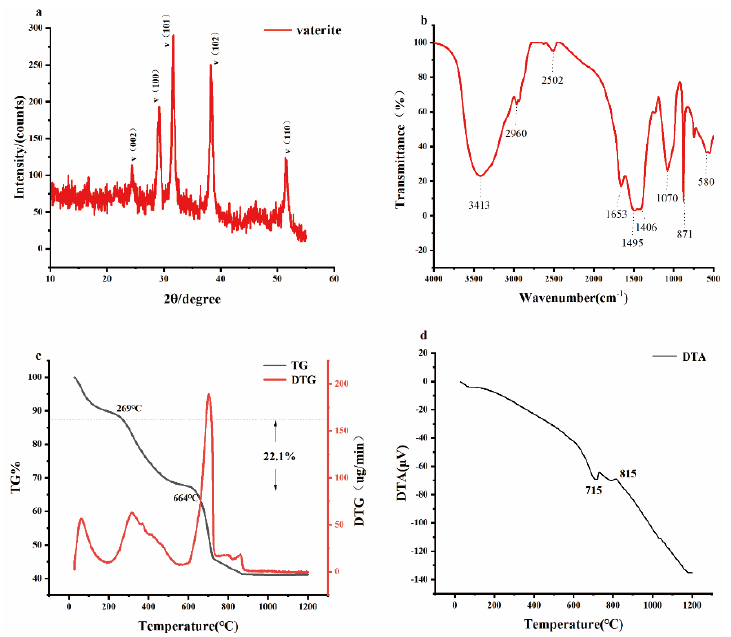
Figure 2. Structural characteristics of BV. ( a ) XRD pattern. ( b ) FTIR pattern. ( c ) TG-DTG curve. ( d ) DTA curve.